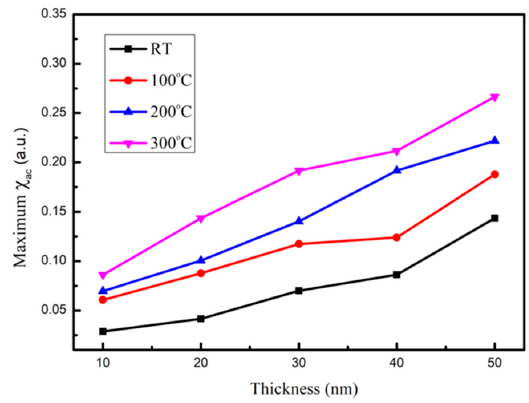
Figure 5. The maximum alternate-current magnetic susceptibility for the CoFeY thin films.